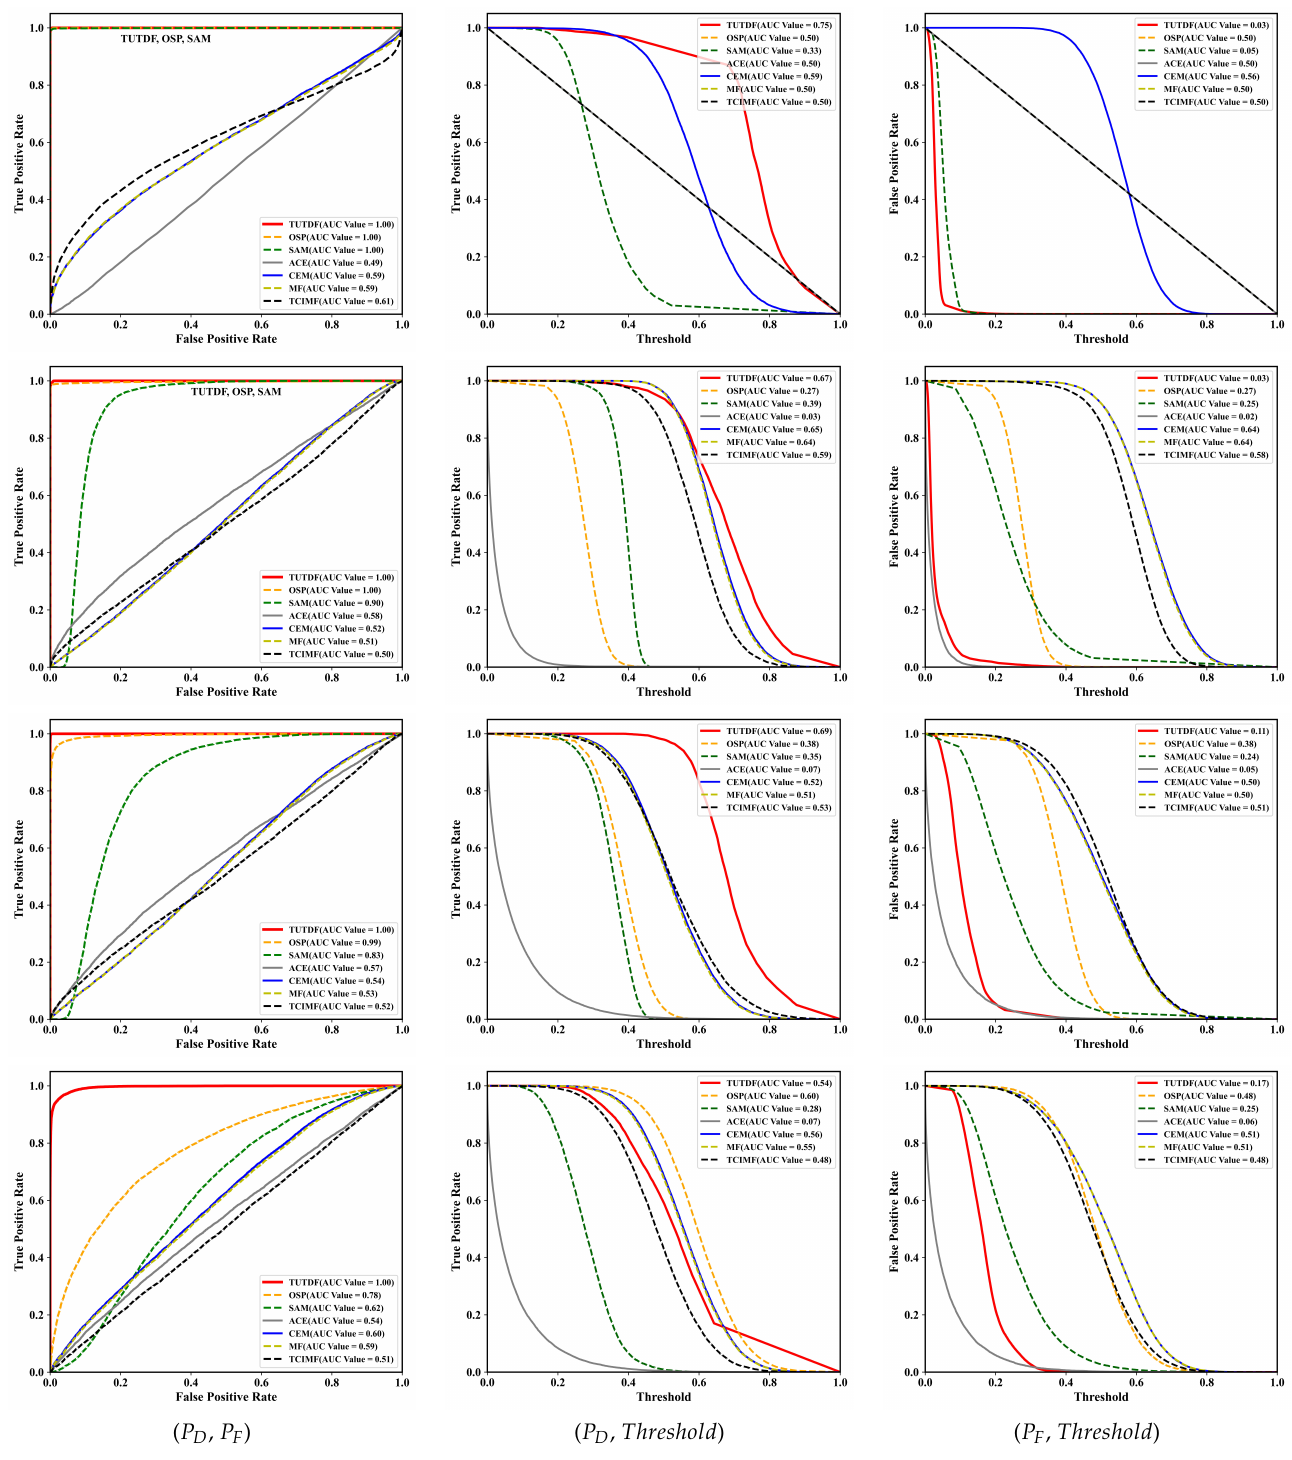
Figure 17. The ROC curves of ( P D , P F ), ( P D , Threshold ), ( P F , Threshold ) for the compared underwater target detection methods on IRON at different depths (0.1, 0.5, 1.0, 1.6 m from top to